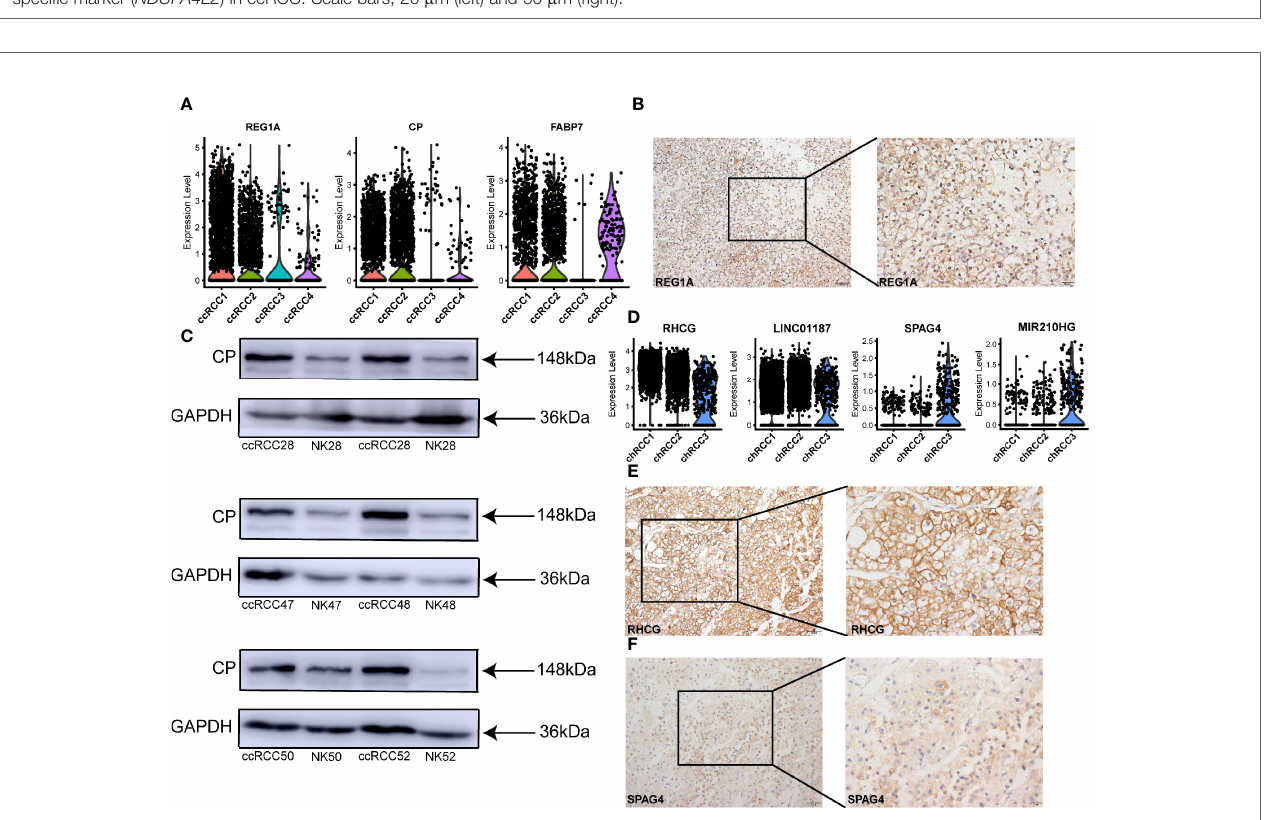
FIGURE 4 | Tumor-speci fi c markers in different types of ccRCC and chRCC. (A) Violin plots showing tumor-speci fi c markers expressed in ccRCC. (B) IHC-P veri fi cation of tumor-speci fi c marker REG1A in ccRCC. Scale bars, 20 m m (left) and 50 m m (right). (C) Western blot was performed showing the expression of CP protein in different ccRCC tissues ( Table S10 ) and normal kidney (NK). (D) Violin plots showing tumor-speci fi c markers expressed in chRCC. (E, F) IHC-P veri fi cation of tumor-speci fi c markers RHCG and SPAG4 in chRCC ( Table S10 ). Scale bars, 20 m m (left) and 50 m m